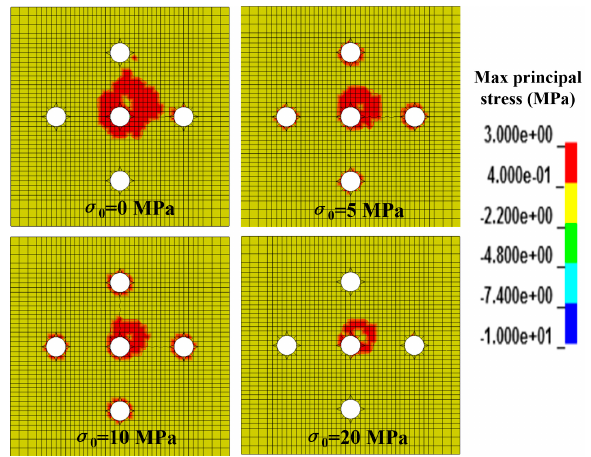
Figure 22. Maximum principal stress contours of the rocks containing five holes under different confining pressures.